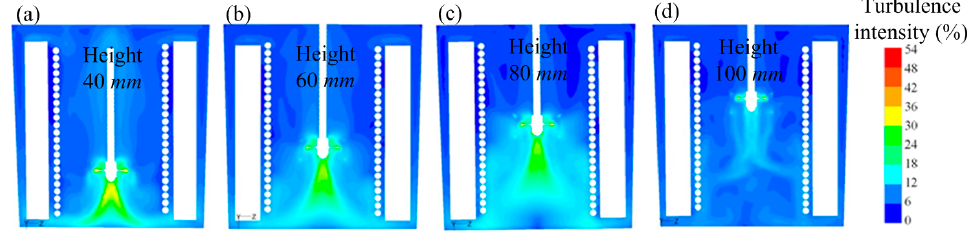
Figure 4. Distribution of fluid turbulence intensity in the system. ( a ) h = 40 mm; ( b ) h = 60 mm; ( c ) h = 80 mm; ( d ) h = 100 mm.